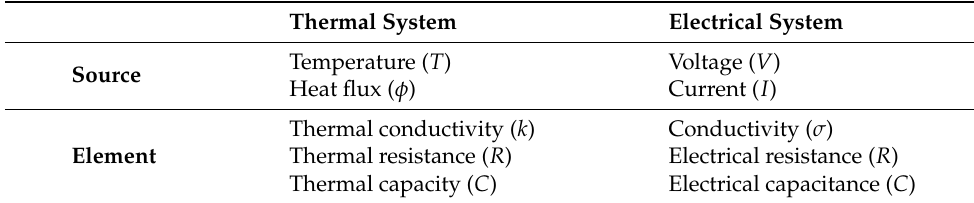
Table 2. Thermal to Electrical System analogy.